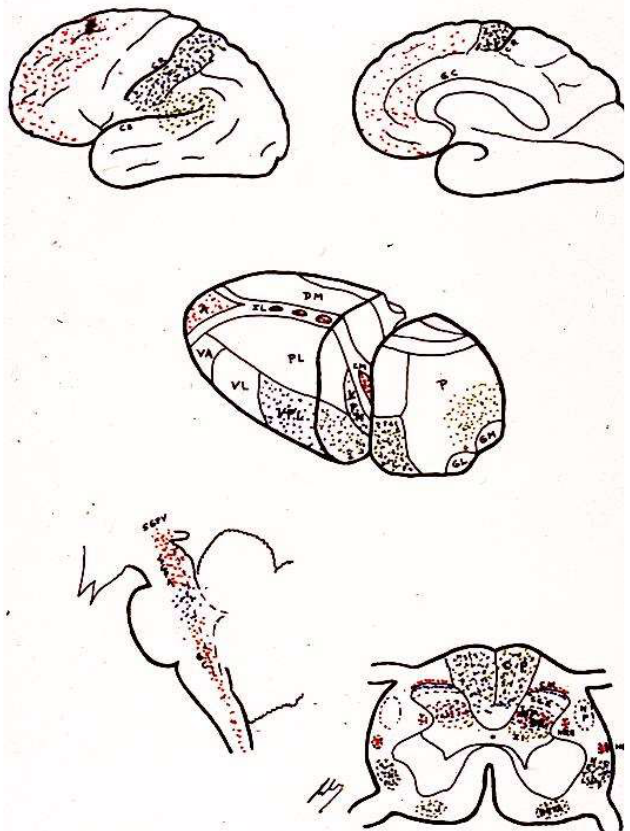
Figure 4. Area distribution according to the neurotransmitters involved (see text). LD (Lateral dorsal nucleus). LP (Lateral posterior nucleus). VL (Ventral lateral nucleus). VA (Ventral anterior nucleus). VL = VPL (Ventral posterolateral). VP = VPM (Ventral posteromedial). A = AN (Anterior nuclear group). DM = MD (Medial dorsal nucleus). P (Pulvinar). GL = LG (Lateral geniculate nucleus).